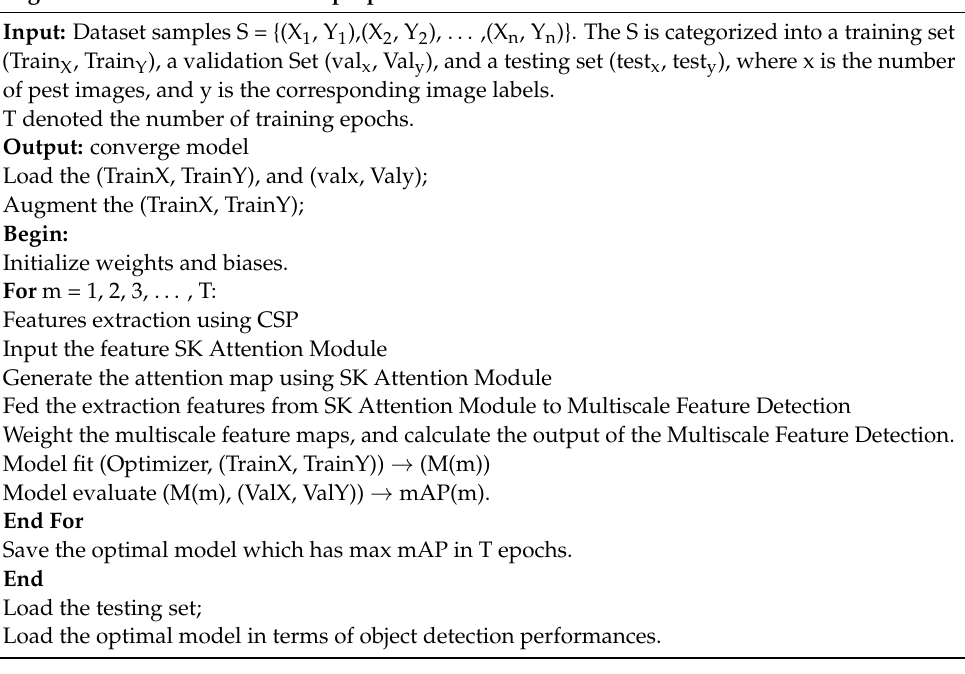
Algorithm 1: Psuedocode of the proposed model